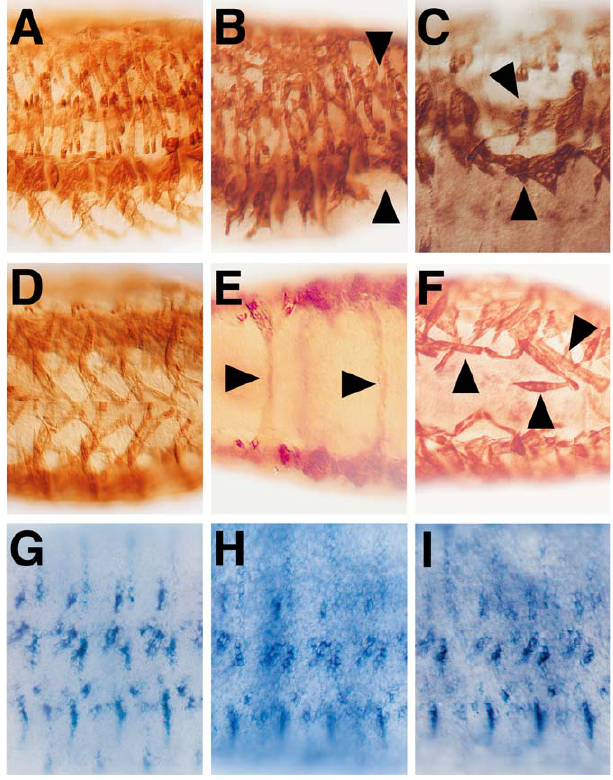
Figure 4. Muscle Pattern Defects in esg and sdc Mutants Muscle pattern of three segments of oreR (A, D, and G), esg L2 (B and H), and sdc 23 mutant embryos (C, E, F, and I) after staining with anti-MHC antibodies or using a delilah transcript-specific anti-sense RNA probe (G– H). Lateral (A–C and G–I) and ventral views (D–F) of embryos at stage 14 (E) and stage 16 (A–D and F–I). esg mutant embryos show variable muscle pattern defects with muscles absent ([B], arrowheads). In sdc mutant embryos few muscles cross the ventral midline in a position dorsal to the central nervous system ([E], arrowheads), and they show disruptions of the pattern in the ventral region ([C], arrowheads). The typical ‘‘ finger-type pattern ’’ of the ventral muscles of wild-type embryos (D) is unordered in sdc 23 mutant embryos, with ventral muscles aligning in parallel with the anterio-posterior axis, ignoring the segment border attachment ([F], arrowheads). Also shown is the pattern of epidermal muscle attachment sites ( delilah marker gene expression) in wild-type (G), esg (H), and sdc (I) mutant embryos. Note that the pattern is unchanged in the